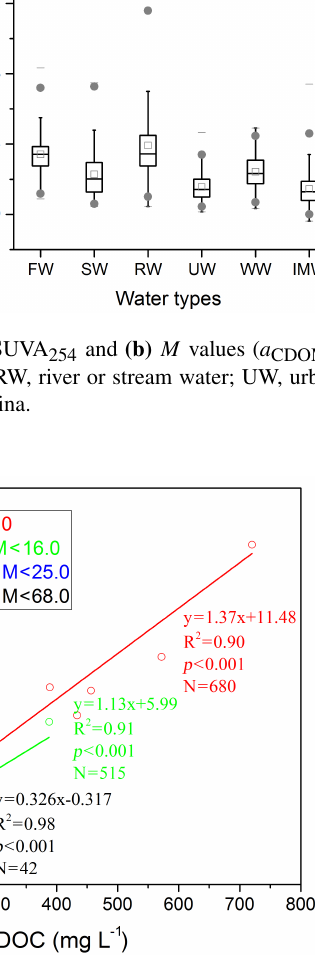
Figure 8. Relationships between DOC and a CDOM 275 sorted by M ( a CDOM ( 250 )/a CDOM (365)) values, Group 1: M < 9 . 0; Group 2: 9 . 0 < M < 16 . 0; Group 3: 16 . 0 < M < 25 . 0; and Group 4: 25 . 0 < M < 68 .